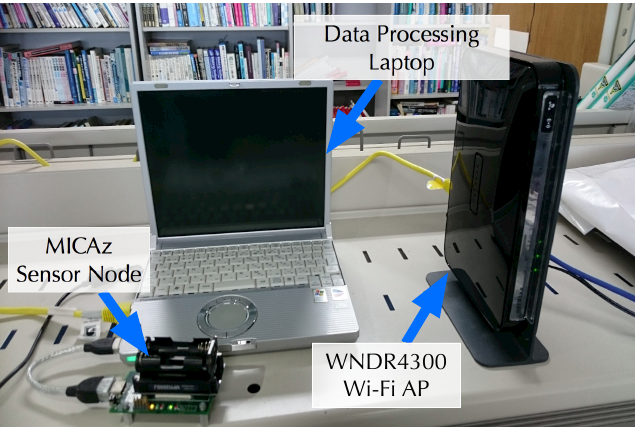
Figure 5. Equipment used in our experimental